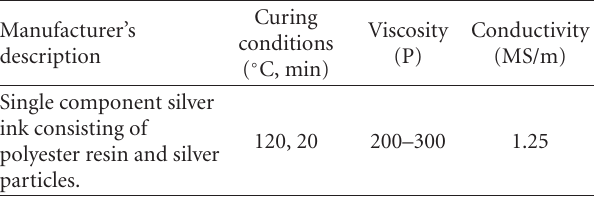
Table 1: Dimensions of di ff erent antenna designs.